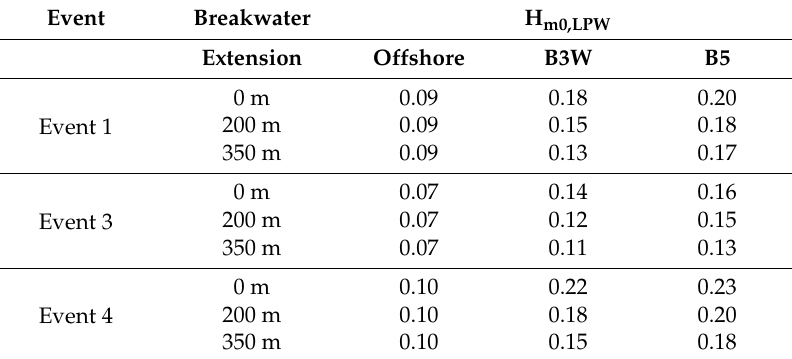
Table 2. Significant long wave height for the considered events and breakwater extensions at the 20 m contour in the channel (Offshore), the western end of Berth 3 (B3W) and the centre of Berth 5 (B5). Event Breakwater H m0,LPW Extension Offshore B3W